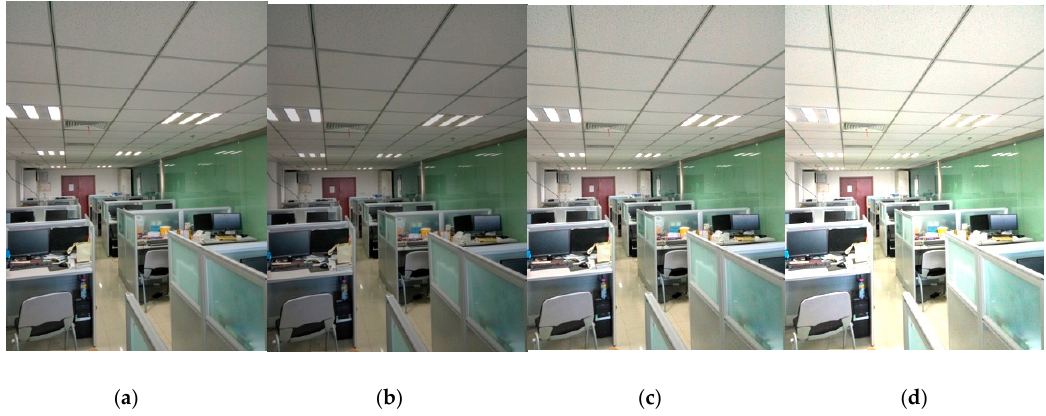
Figure 8. An example of an image with different luminous intensities. This is the indoor environment of our lab room. ( a ) Baseline; ( b ) 80% brightness; ( c ) 120% brightness; ( d ) 140% brightness.